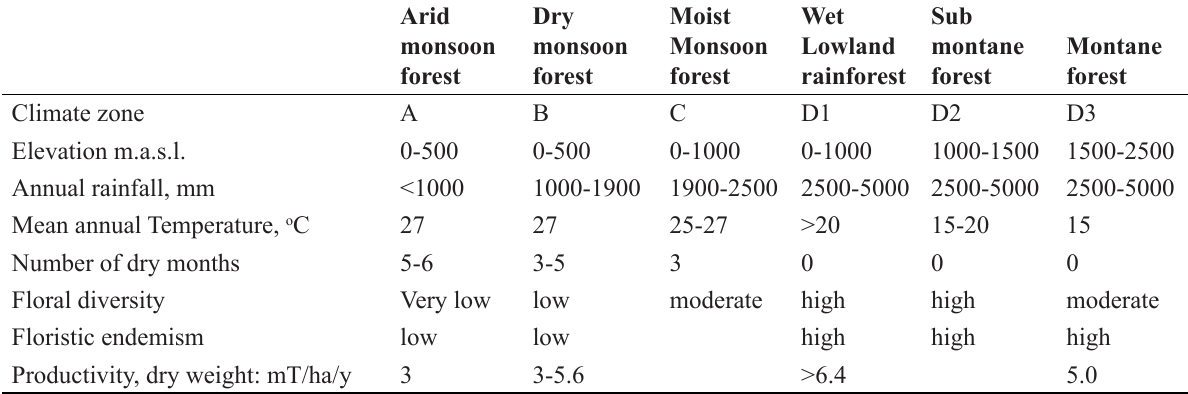
Table 1: Climatic and biotic properties typical of the major climatic zones and forest types of Sri